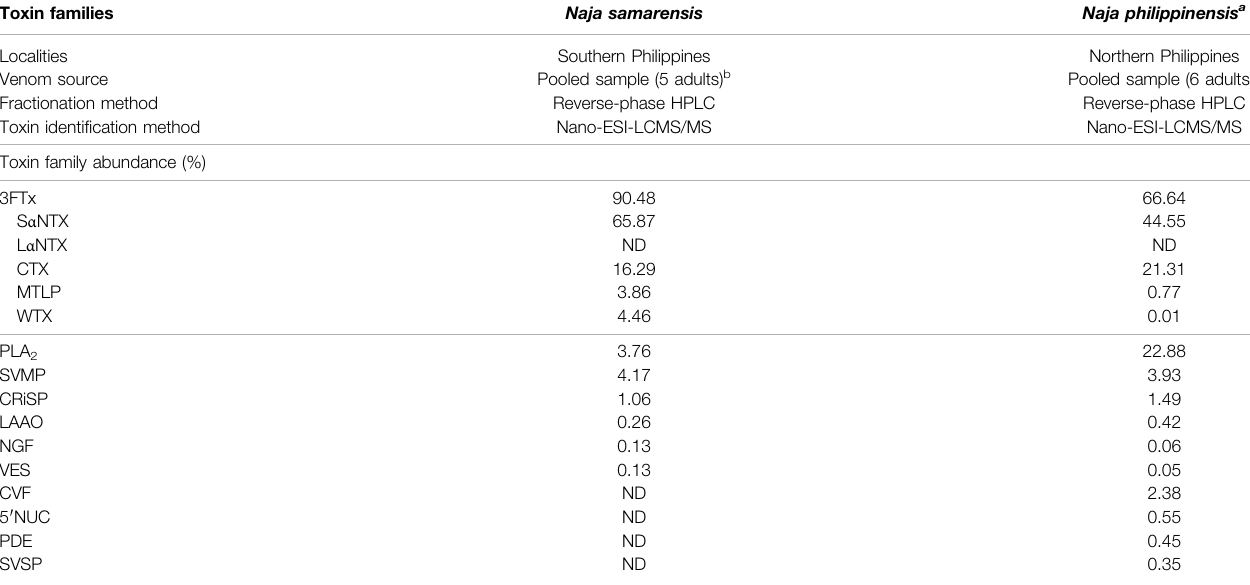
TABLE 3 | Comparison of venom toxin families of Naja samarensis and Naja philippinensis . Toxin families Localities